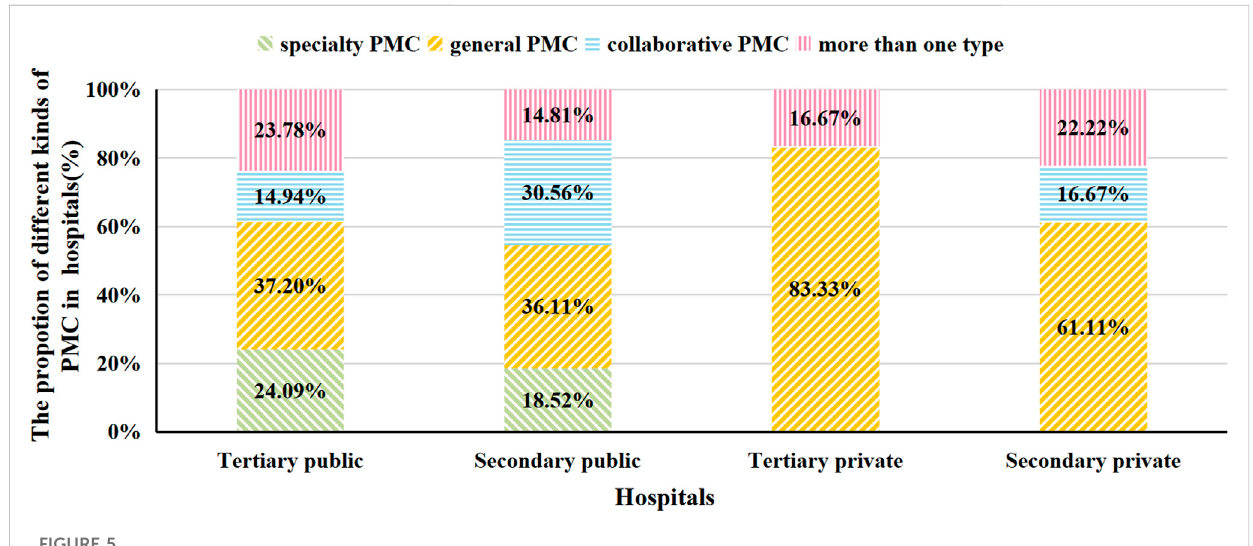
FIGURE 5 The proportion of different kinds of PMC in